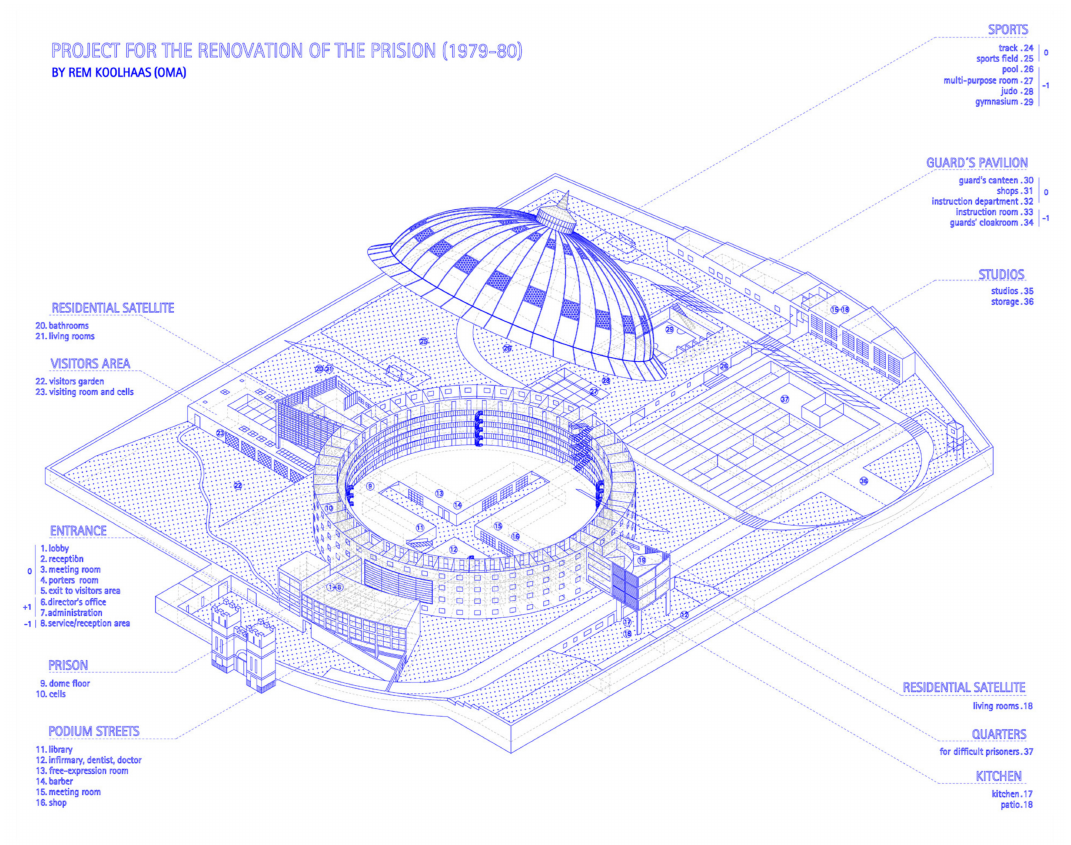
Figure 5. Drawing made for this analysis of the Koepelgevangenis renovation project in Arnhem, Netherlands